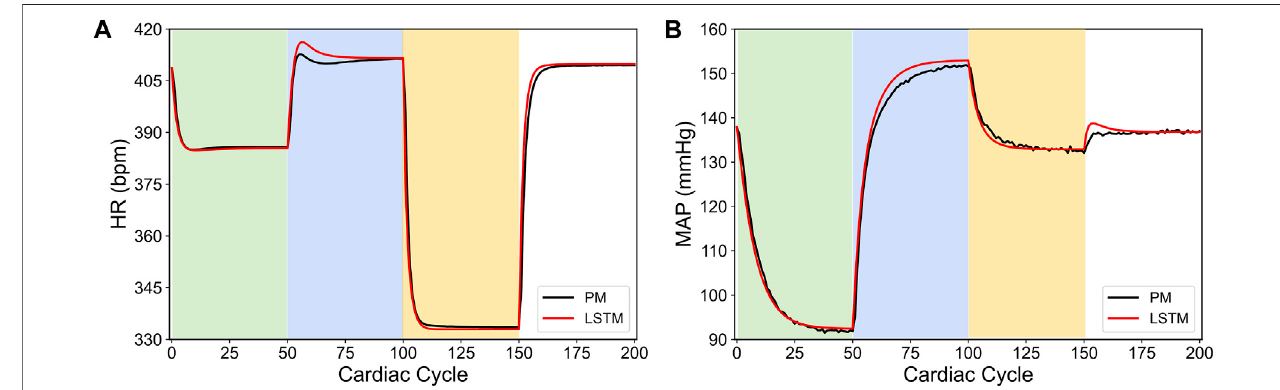
FIGURE 1 | LSTM predictions (shown in red) compared to the output from the in silico physiological model of the rat cardiac system (PM, shown in black) for 200 simulated cardiac cycles of (A) heart rate and (B) mean arterial blood pressure (MAP). For cycles 1 – 50 (light green), location 1 was active with a pulse width of 0.36 ms andpulsefrequencyof31 Hz.Forcycles51 – 100(lightblue),location2wasactivewithapulsewidth0.19 msandapulsefrequency17 Hz.Forcycles101 – 150(yellow), location 3 was active with a pulse width of 0.42 ms and a pulse frequency of 47 Hz. The last 50 cycles did not have any locations active.